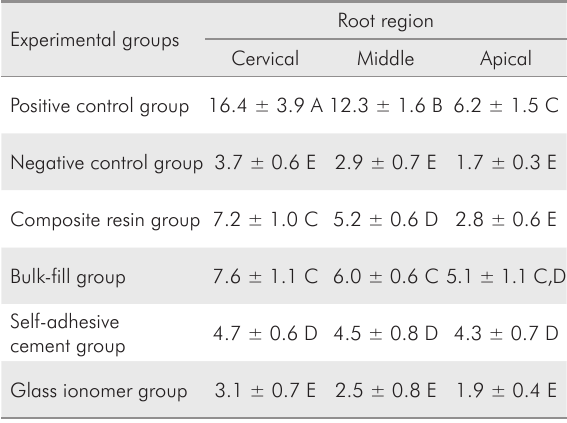
Table 2. Mean values ± standard deviation of bond strength (MPa) for the experimental